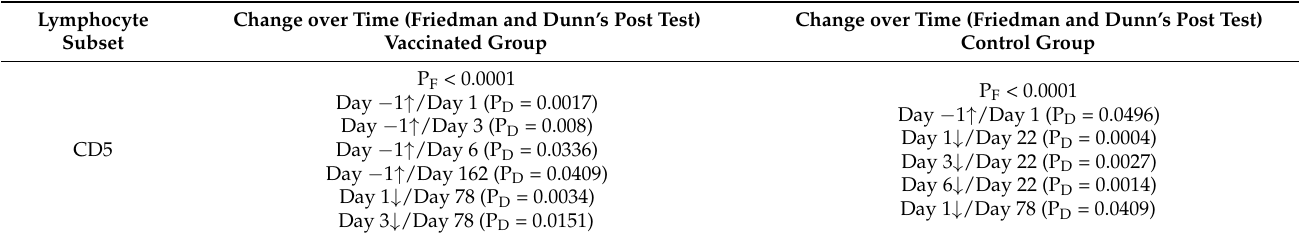
Table A5. Results of the Friedman and Dunn’s post test of lymphocyte subsets after FCV Challenge I. Lymphocyte Change over Time (Friedman and Dunn’s Post Test) Subset Vaccinated Group